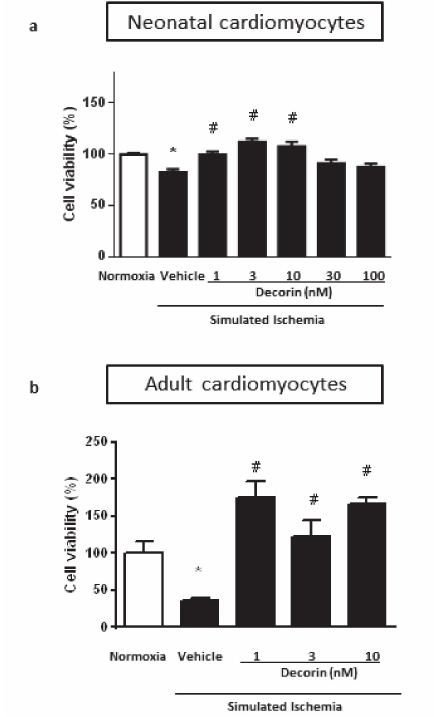
Figure 2. The e ff ect of di ff erent concentrations of decorin on cell viability in isolated ( a ) NRCMs and ( b ) Adult Rat Cardiac Myocytes (ARCMs) exposed to SI / R. Data are normalized to vehicle-treated Normoxia and presented as mean ± S.E.M. One-Way ANOVA, Dunnett’s multiple comparison test, * p < 0.05 vs. Normoxia and # p < 0.05 vs. SI / R Vehicle treated cells ( n = 5–6). 2.3. The E ff ect of Di ff erent Inhibitors of Survival Pathways on Decorin-Induced Cardioprotection in